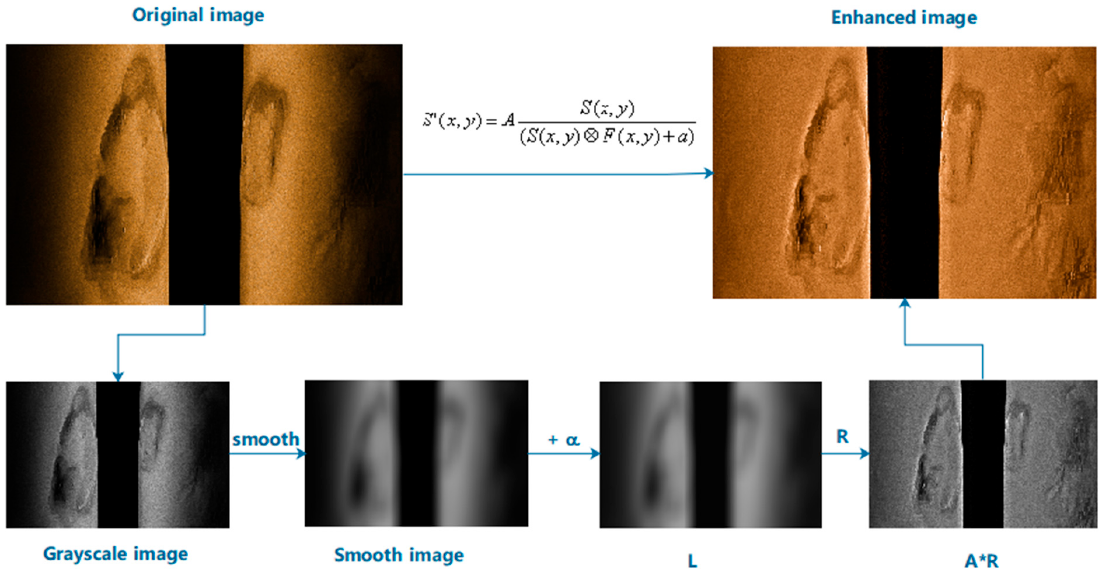
Figure 3. The overall framework of the algorithm in this paper.